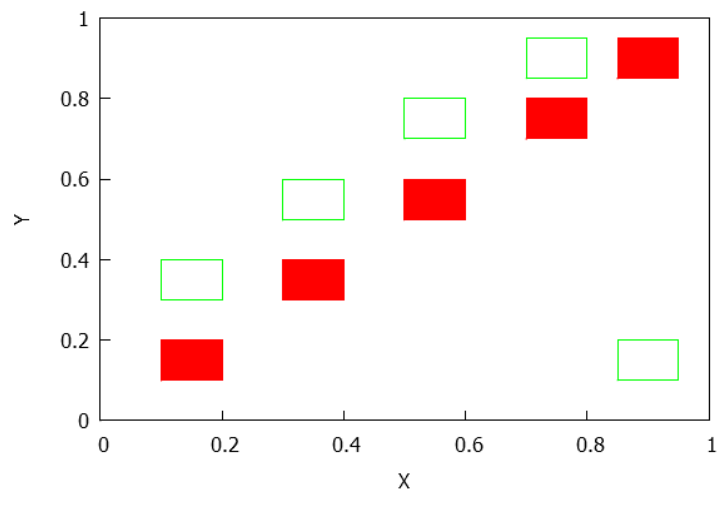
Figure 4. Two equivalent limit